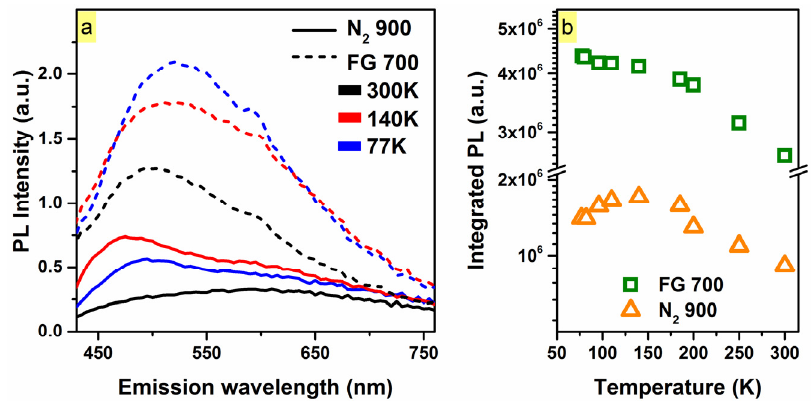
Figure 4. ( a ) Temperature-dependent steady-state photoluminescence spectra of the N 2 900 °C (solid) and FG 700 °C passivated (dashed) O-rich sample under 400 nm excitation. Two components were observed at ~470 and ~580 nm; ( b ) I PL as a function of temperature for the corresponding passivated samples. The N 2 -passivated sample exhibited stronger temperature dependence, with the I PL nearly doubling from 300 to 140 K.